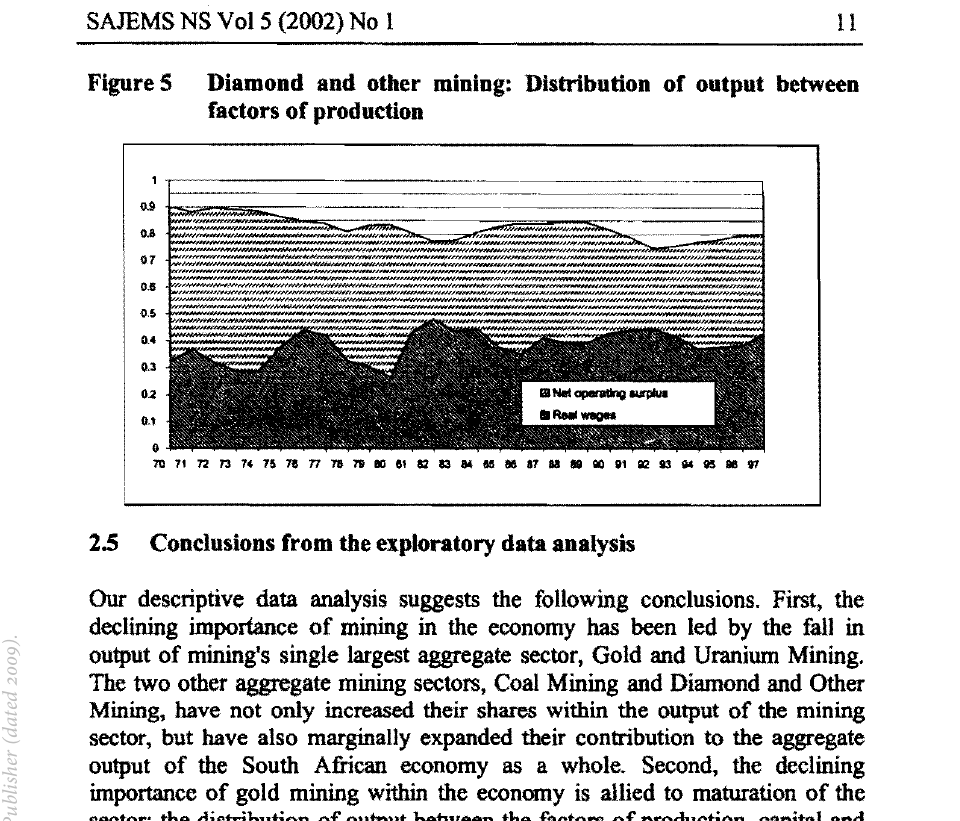
Diamond and other mining: Distribution of output between factors of